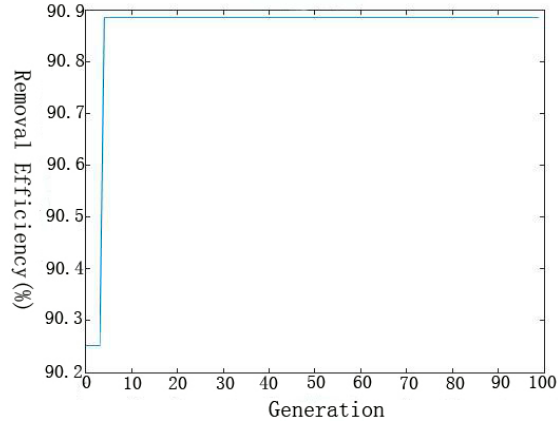
Figure 8. Evolvement of fitness with 100 generations.